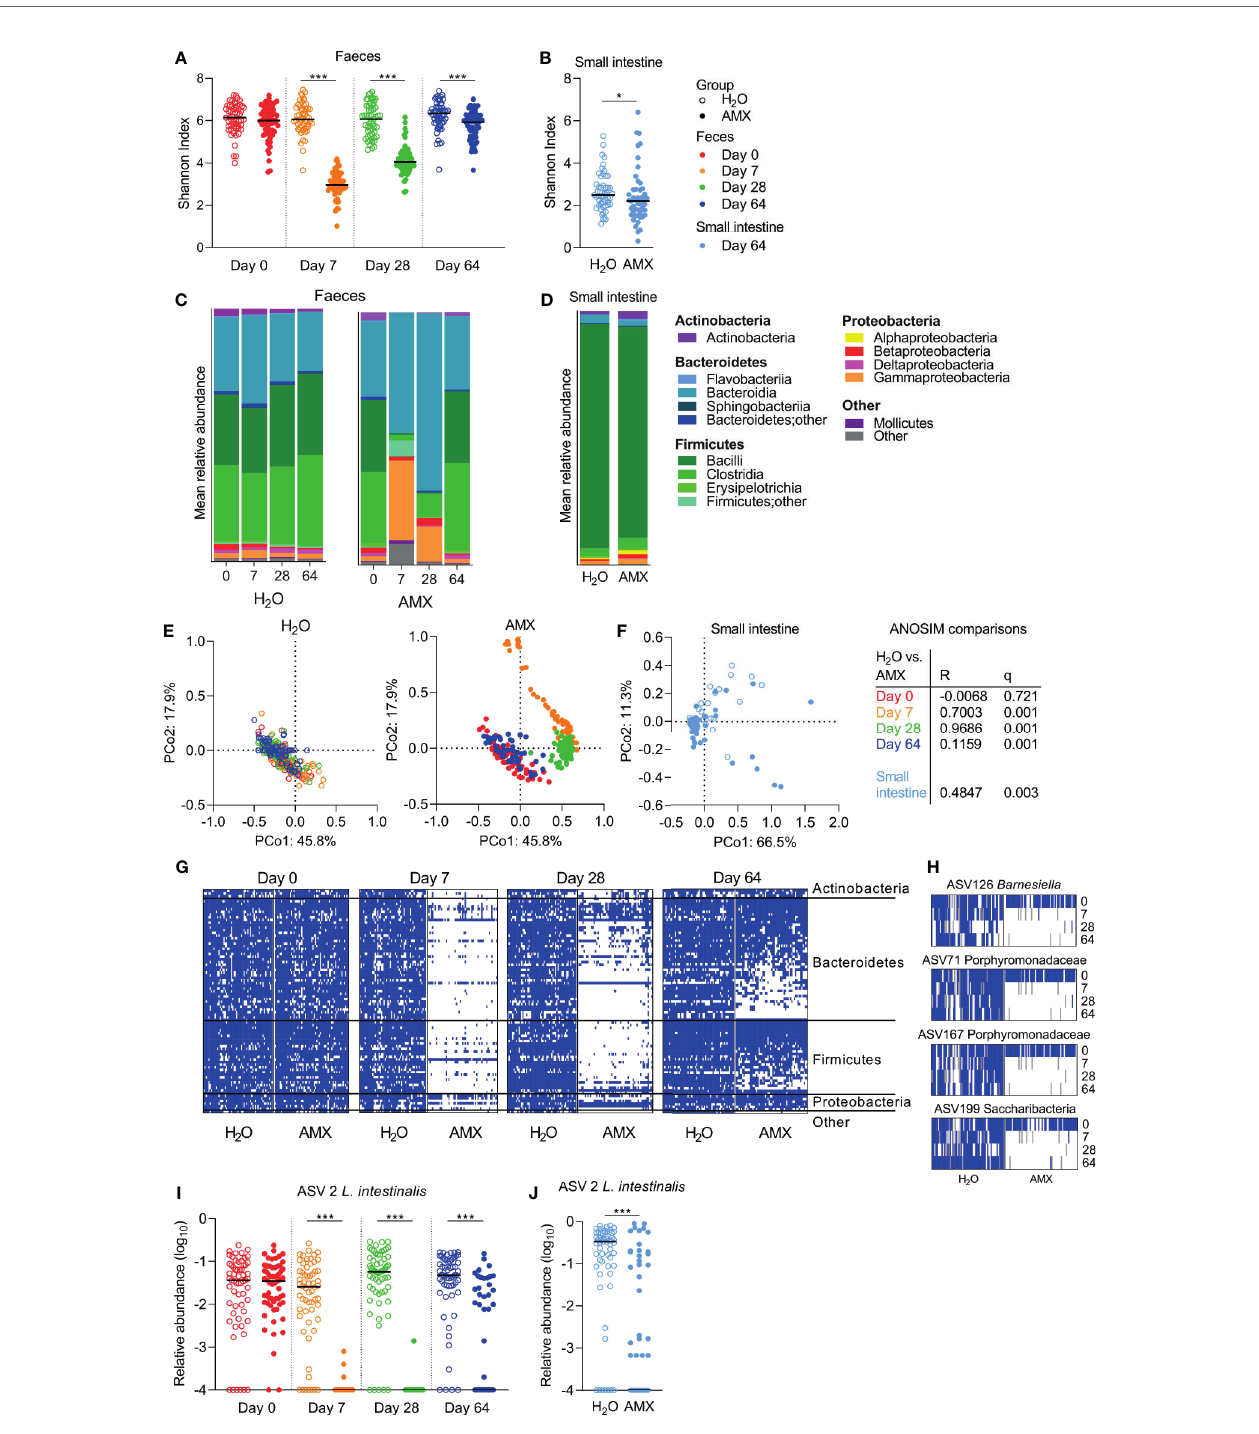
FIGURE 4 | Effects of amoxicillin on faecal and small intestine microbiota. Shannon diversity index offaecal (A) and small intestinal (B) microbiota of conventional (H 2 O, open symbols) and amoxicillin (AMX, closed symbols) groups. Mean relative abundance of bacterial classes in faecal (C) and small intestinal (D) microbiota. Principal coordinate analysis (PCoA) plots of weighted UniFrac distances in faecal (E) and small intestinal (F) samples are coloured according to sample day. Pairwise comparisons between the H 2 O and AMX groups at different days in faeces and in small intestine by analysis of similarities (ANOSIM). Presence/absence status of the most prevalent amplicon sequencing variant (ASVs), present in ≥ 75% of the rats on Day 0, in the faecal samples at different days (G) . Presence (blue)/absence (white)/missing data (grey) status of four ASVs at different days (H) . Relative abundance of Lactobacillus intestinalis in faecal (I) and small intestinal (J) microbiota. Each symbol represents a single rat and horizontal lines indicate median (A, B, H, I) values. Statistically signi fi cant differences between groups are indicated as *p ≤ 0.05, ***p ≤